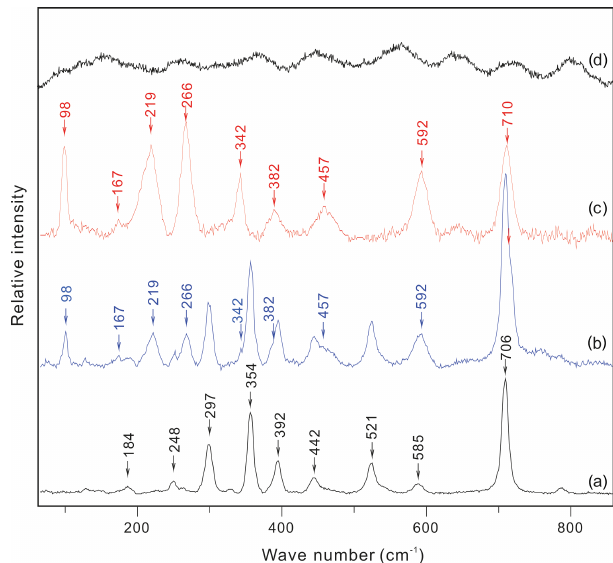
Figure 3. Raman spectra of (a) inclusion-free spodumene, (b) a hydrous solid phase in the spodumene-hosting crystal-rich inclu- sions, and (c) recrystallized cookeite in the HDAC sample cham- ber. (d) Natural cookeite before crystallization experiments from the Minas Gerais pegmatite, Brazil, which bears high fluorescence even when collected for 1s with an excitation beam of 633nm wave- length through a 100 × Olympus objective lens (NA = 0 . 90). The characteristic Raman peaks are marked.